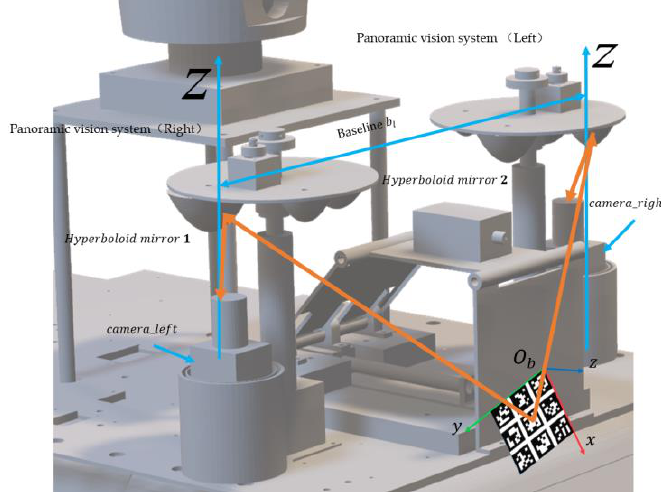
Figure 12. Schematic diagram of binocular stereo panoramic calibration.